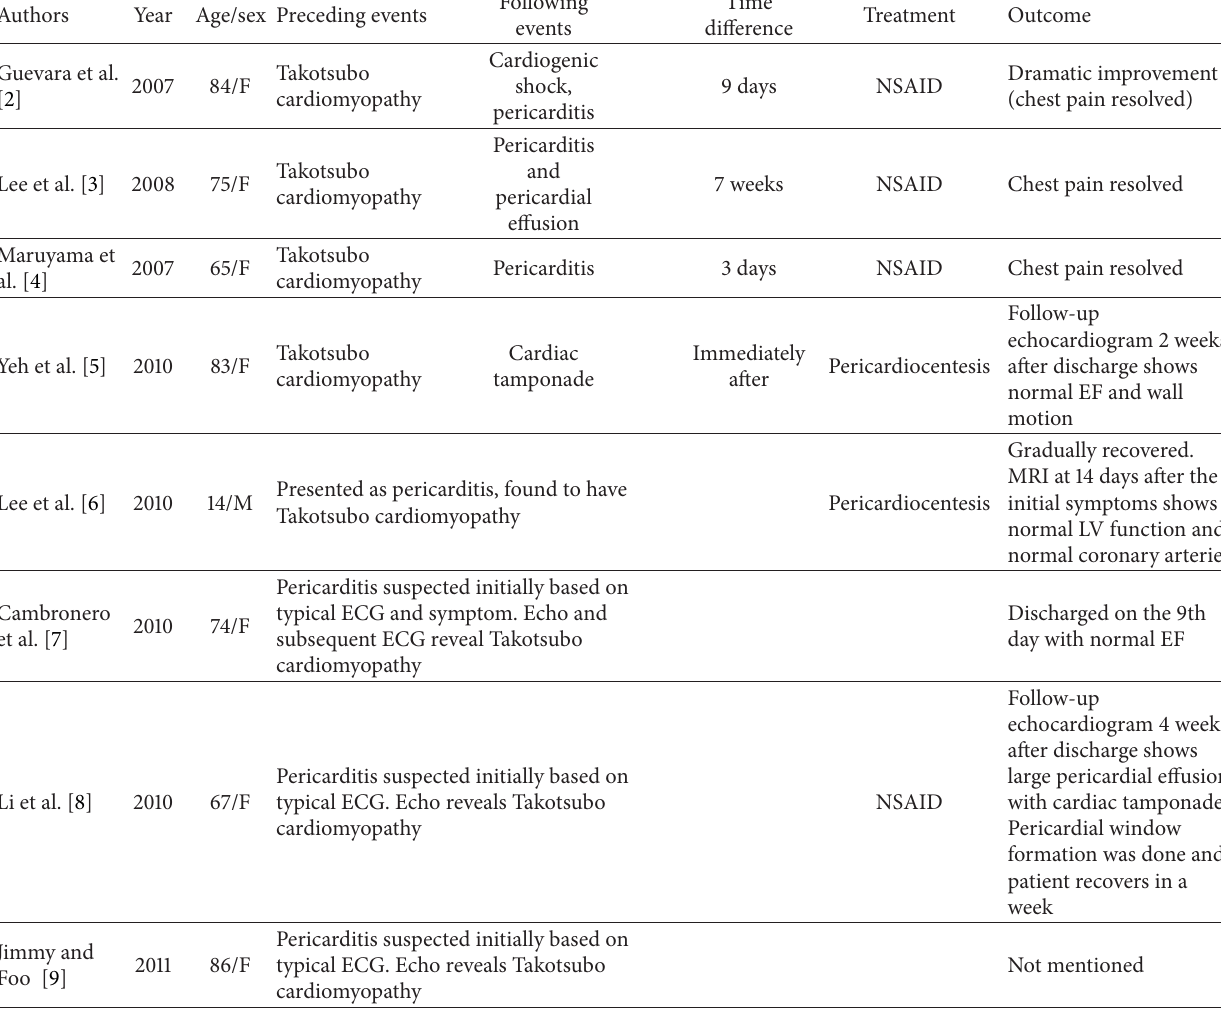
Table 1: Reported cases with regards to TC and pericarditis